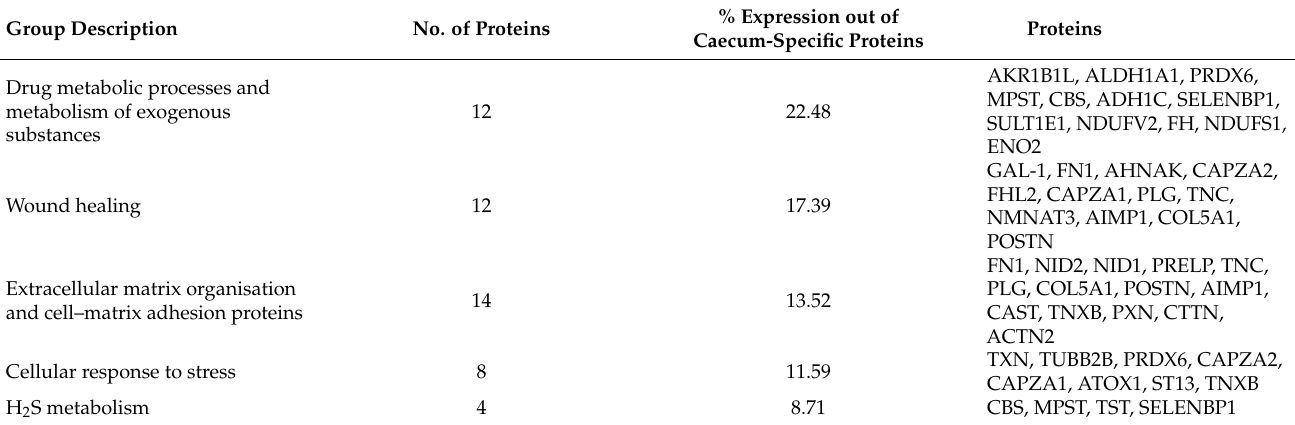
Figure 2. Caecum-specific proteins network generated by STRING. Size of the nodes is proportional to the caecum protein expression. Caecum exclusive proteins, i.e., proteins not expressed in the ileum at all, are highlighted in bold. Table 4. Caecum-specific proteins grouped according to